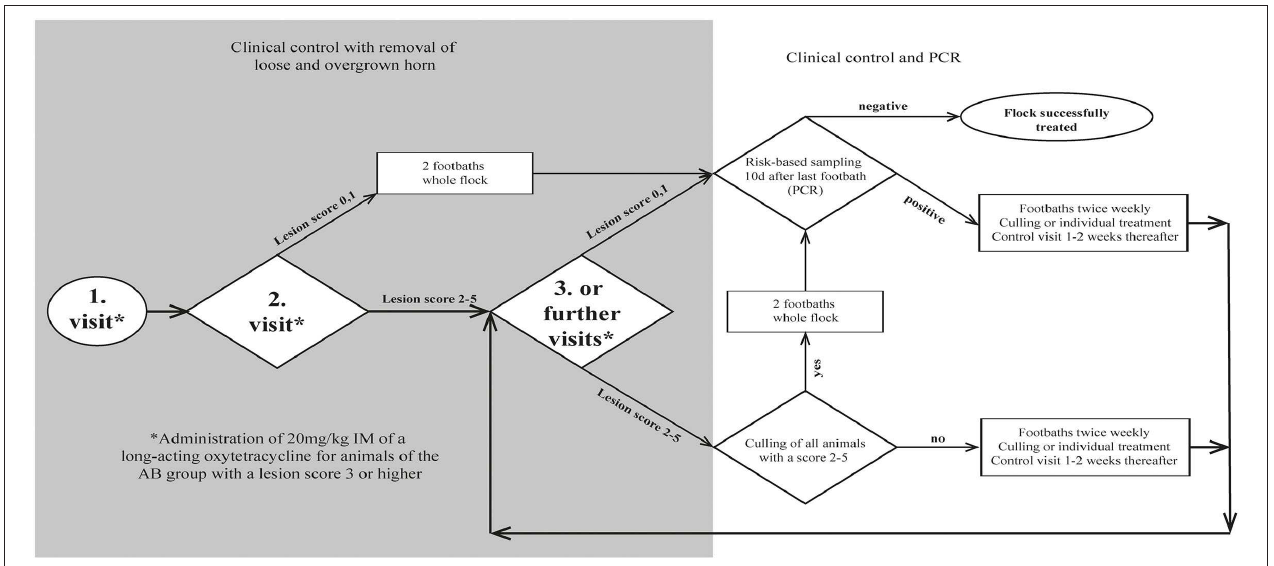
FIGURE 1 | Flow chart for decision making during treatment of 18 sheep flocks with an aprV2- positive footrot